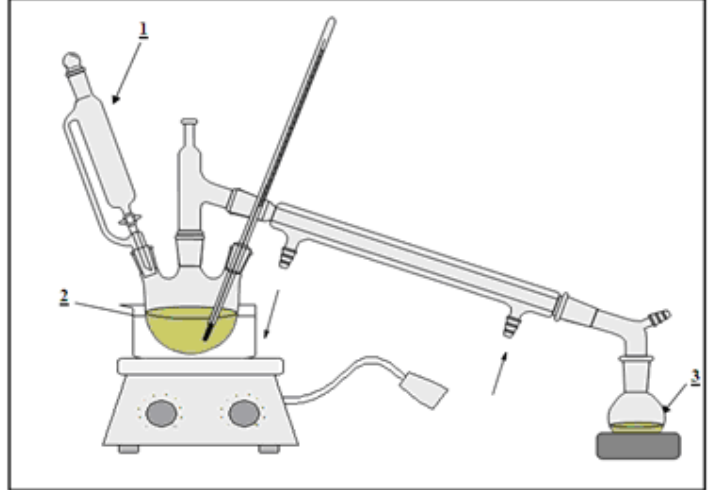
1: alcohol; 2: fatty acid + clay; 3: alcohol +